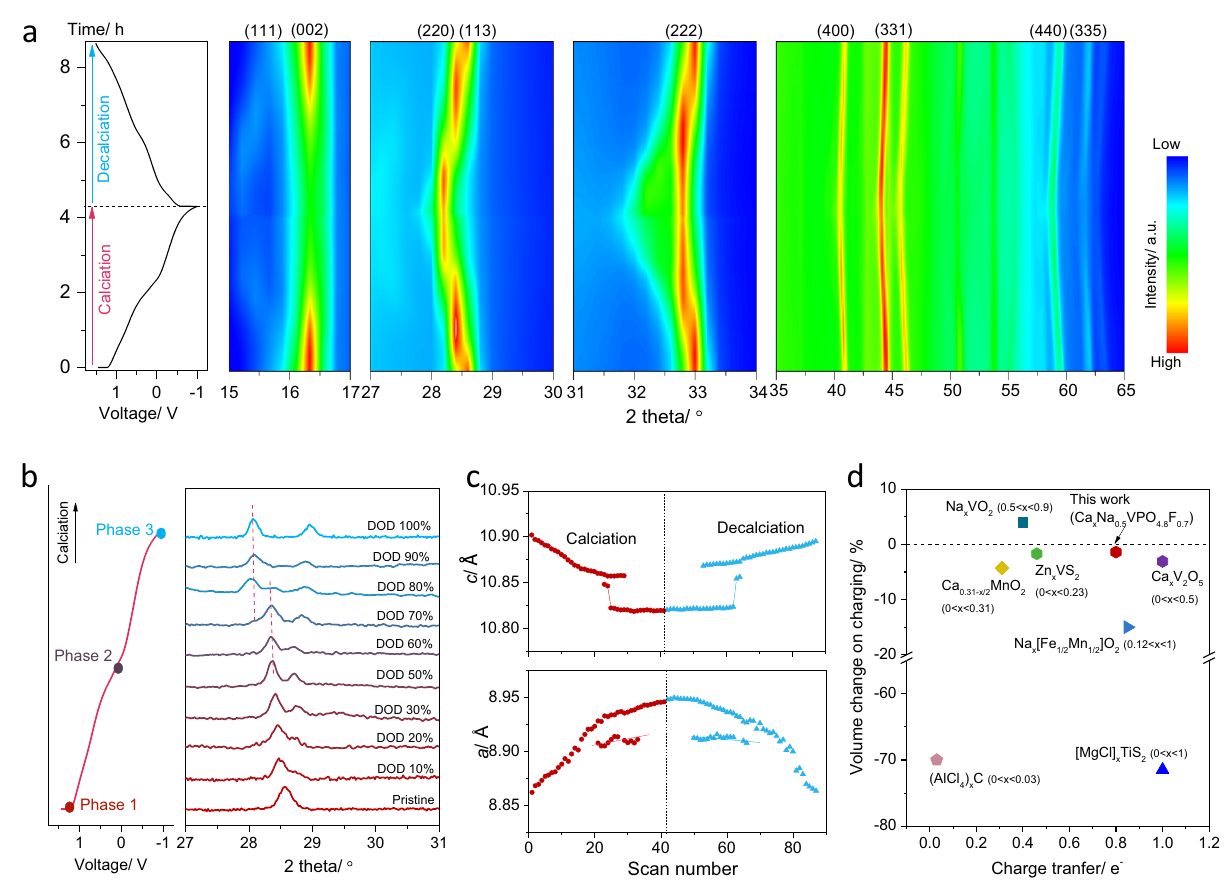
Fig. 2 Synchrotron in situ XRD analysis of the structural evolution of desodiated NVPF cathode during calciation and decalciation. a Discharge/charge voltage pro fi le and the corresponding in situ XRD intensity map, where blue refers to low intensity and red corresponds to high intensity. b Evolutions of (220) and (113) re fl ections of the in situ XRD patterns at different depth of discharge; the left shows the typical voltage pro fi le of desodiated NVPF upon calciation; Phase 1 and 3 represent the pristine phase (desodiated NVPF) and the fully calciated phase, respectively. c Changes in lattice parameters of a and c during calciation and decalciation derived from in situ XRD patterns in a . d Comparison of volume changes on charging in various cathodes as a function of charge transfer number 6,17,28,30 – 33